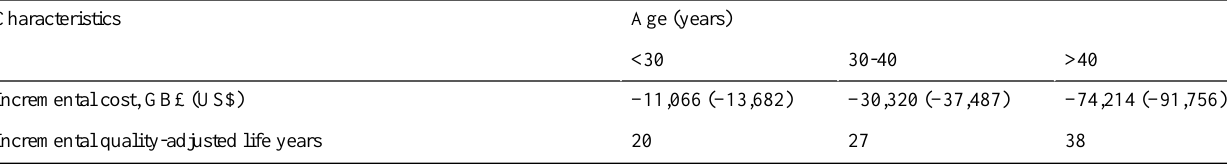
Table 1. A summary of incremental costs and quality-adjusted life years gained per 1000 participants.